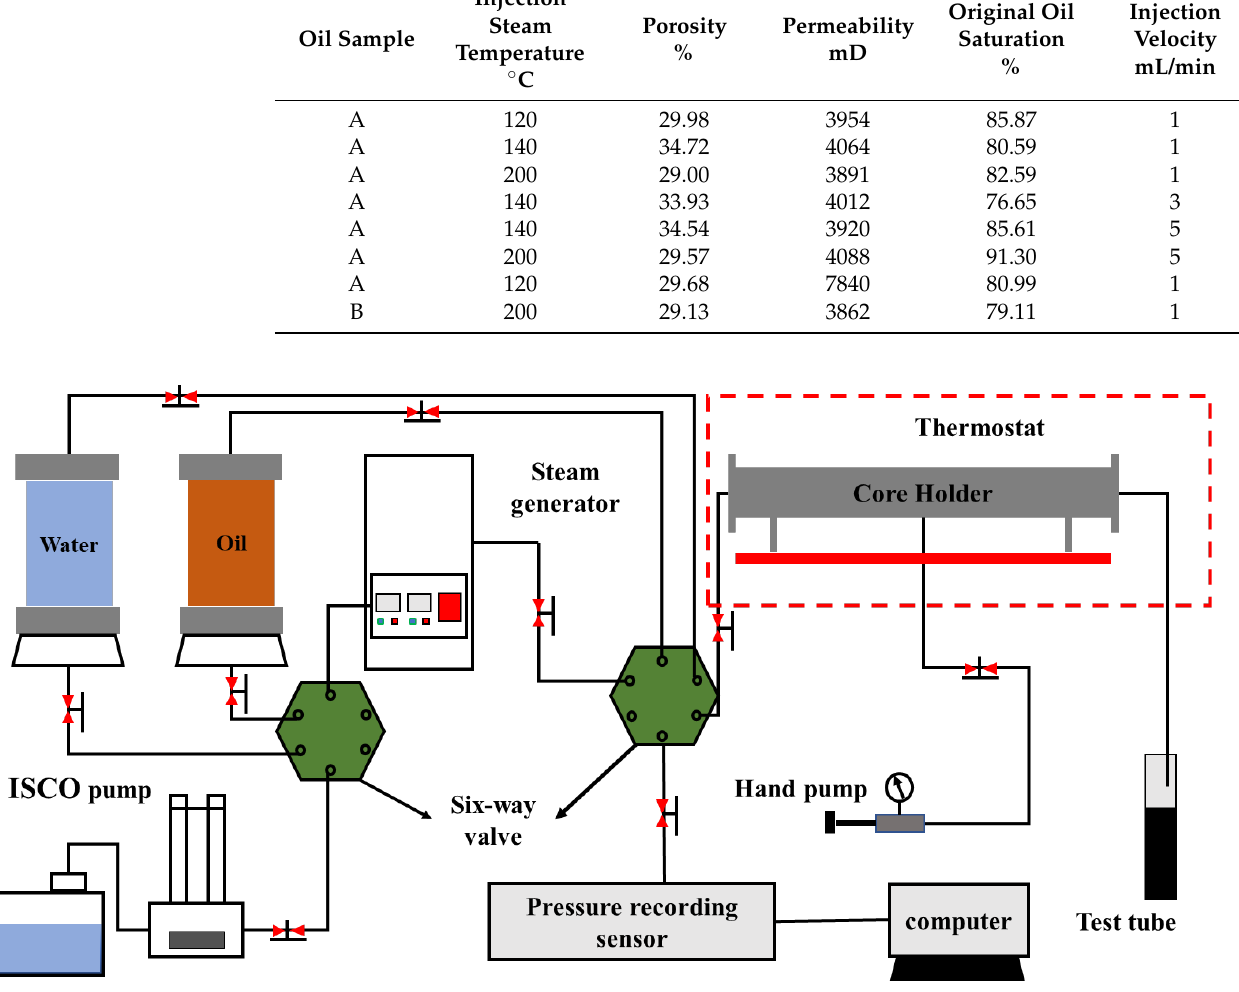
Figure 1. Schematic diagram of the steam flooding experiment system.